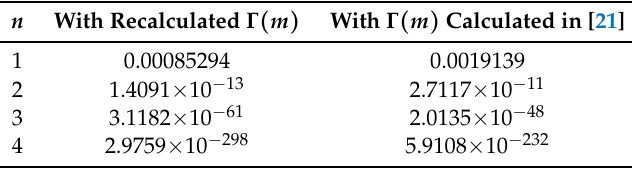
Table 1. Comparison of the error bounds for Method 2. n With Recalculated Γ ( m ) With Γ ( m ) Calculated in